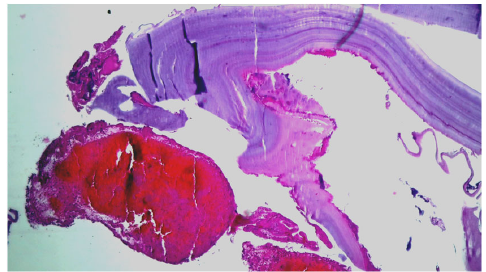
Figure 4. Histopathological examination: HE × 40: anhistous membrane fragment with associated dense inflammatory infiltrate.